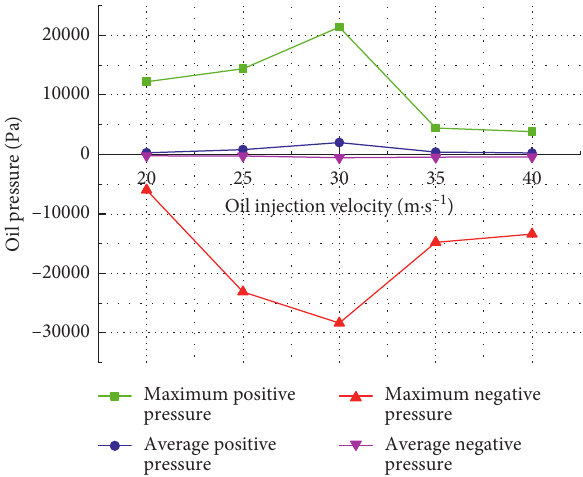
Figure 11: Oil pressure line diagram against different injection